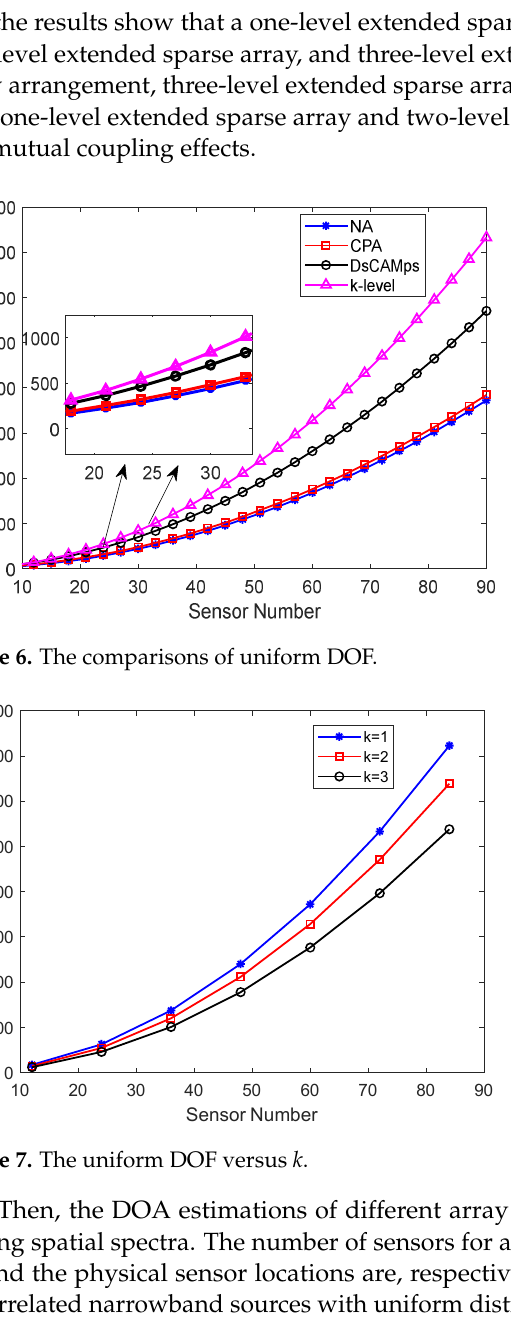
Figure 5. The CARR versus k .